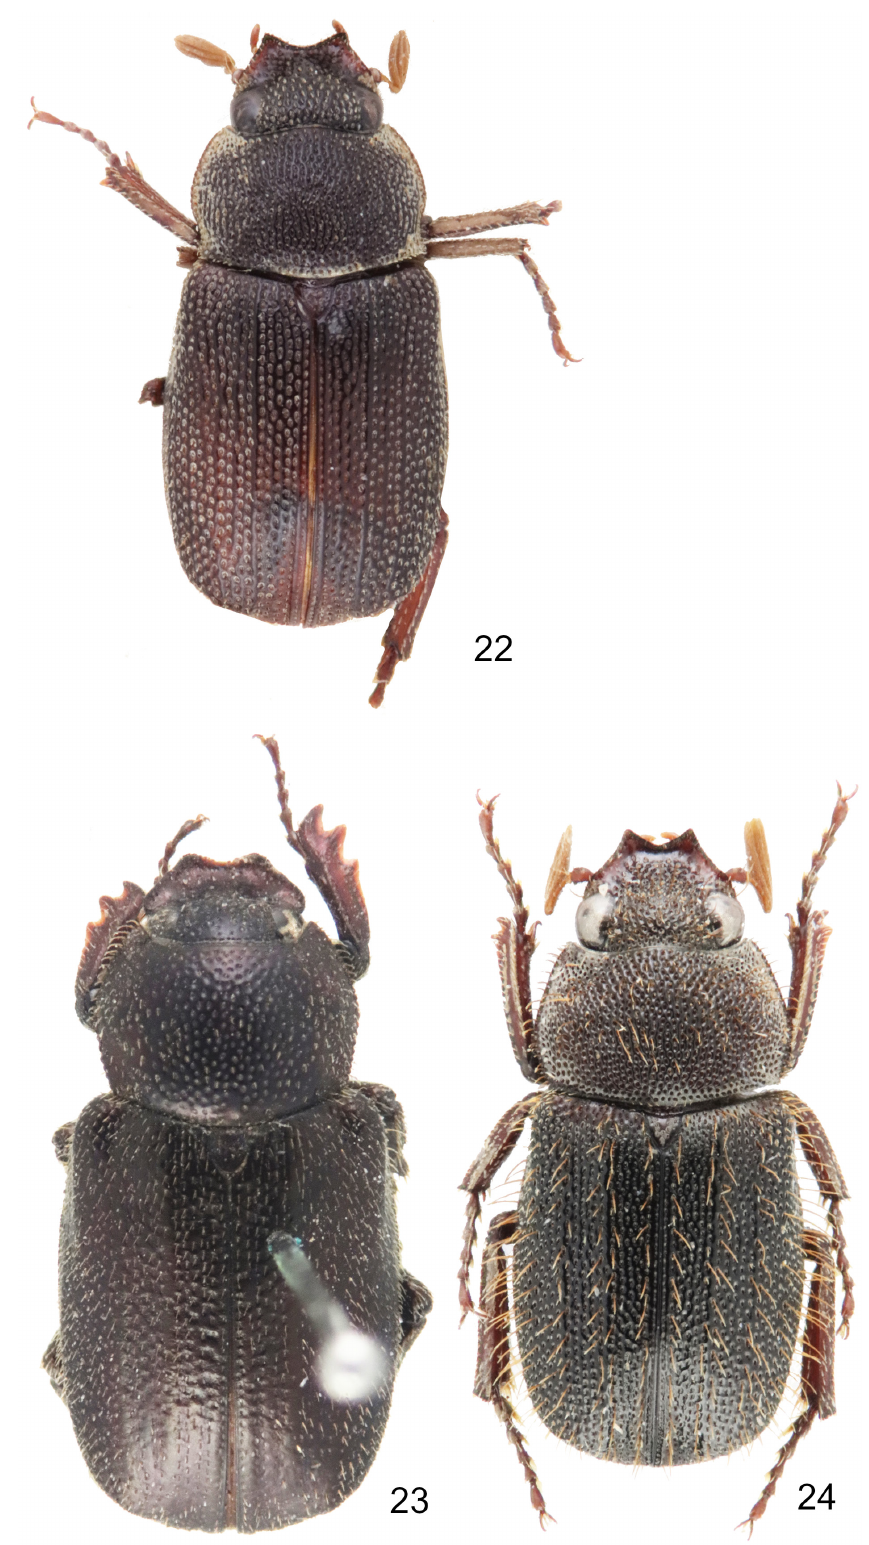
Figs 22–24. Papuan and Wallacean Maechidius Macleay, 1819, habitus, dorsal view. 22 . M. angusticeps Arrow, 1941, holotype, ♂ (BMNH). 23 . M. aroae Heller, 1914, lectotype, ♀ (SNSD). 24 . M. awu sp. nov., holotype, ♂ (IECA). Not to